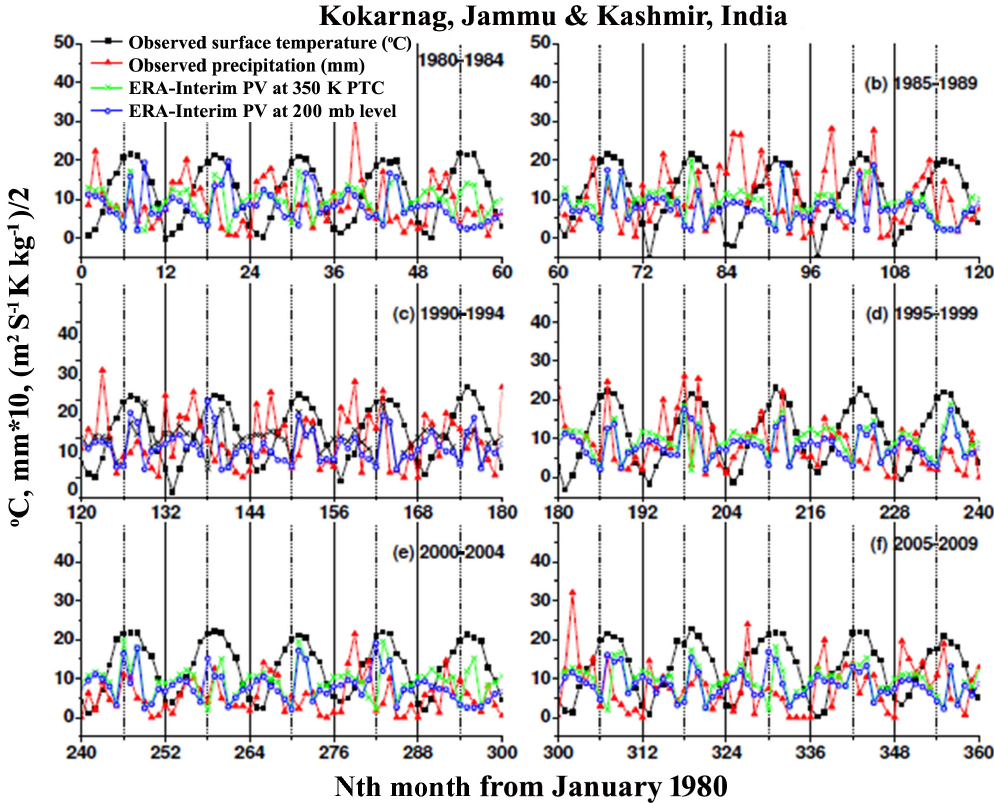
Figure 8. Same as Fig. 6 but for